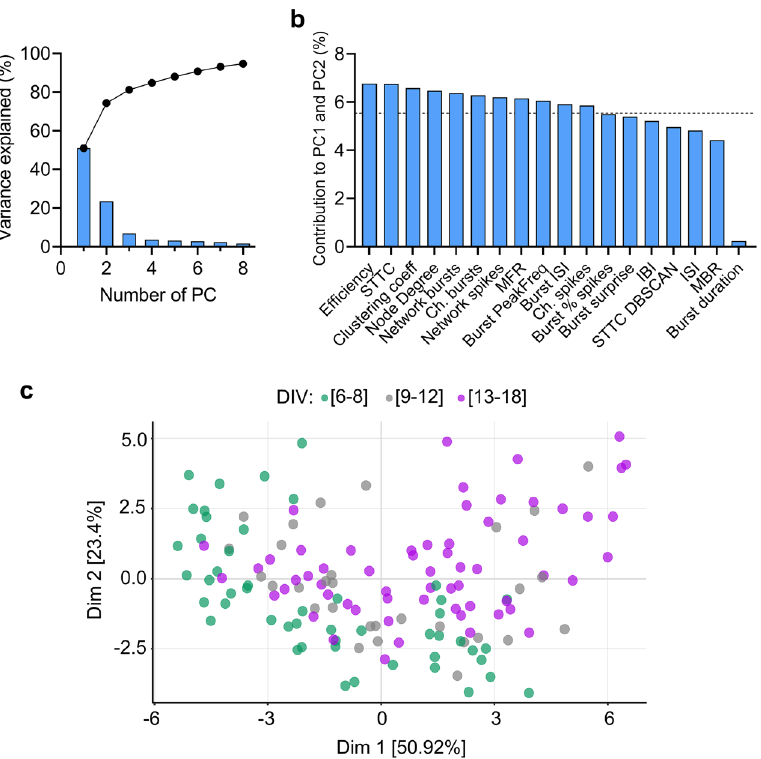
Figure 3. Principal Component Analysis (PCA) of electrophysiological features of neuronal network activity in vitro. ( a ) The graph shows the percentage of variance explained by each principal component (PC) (bars) and the cumulative percentage of variance (dots) by the number of PCs. ( b ) Bar plot displays the contribution (%) of each of the 18 electrophysiological features to the PC1 and PC2. The dotted line represents the significant contribution value (5.55%) for the first two PCs. ( c ) Scatter plot of MEA recordings grouped by DIV intervals in the 2-dimensional PCA based on the 18 electrophysiological features. PC 1 (x-axis) and PC2 (y-axis) captured 74.3% of the total variance and each dot represents a time point recording within each DIV interval: 6–8 (green), 9–12 (gray), and 13–18 (purple) DIV. A gradient from young (DIV 6–8) to mature neuronal networks (DIV 13–18) is captured by the PCA projection: 38.3% of DIV 13–18 recordings are in the positive plane of PC1 and PC2 dimensions while no DIV 6–8 recordings are in the same PC area. The figure was created using Graphpad 8.0 (https:// www. graph pad. com) ( a , b ), and R 4.03 (https:// www.r- proje ct. org/) ( c